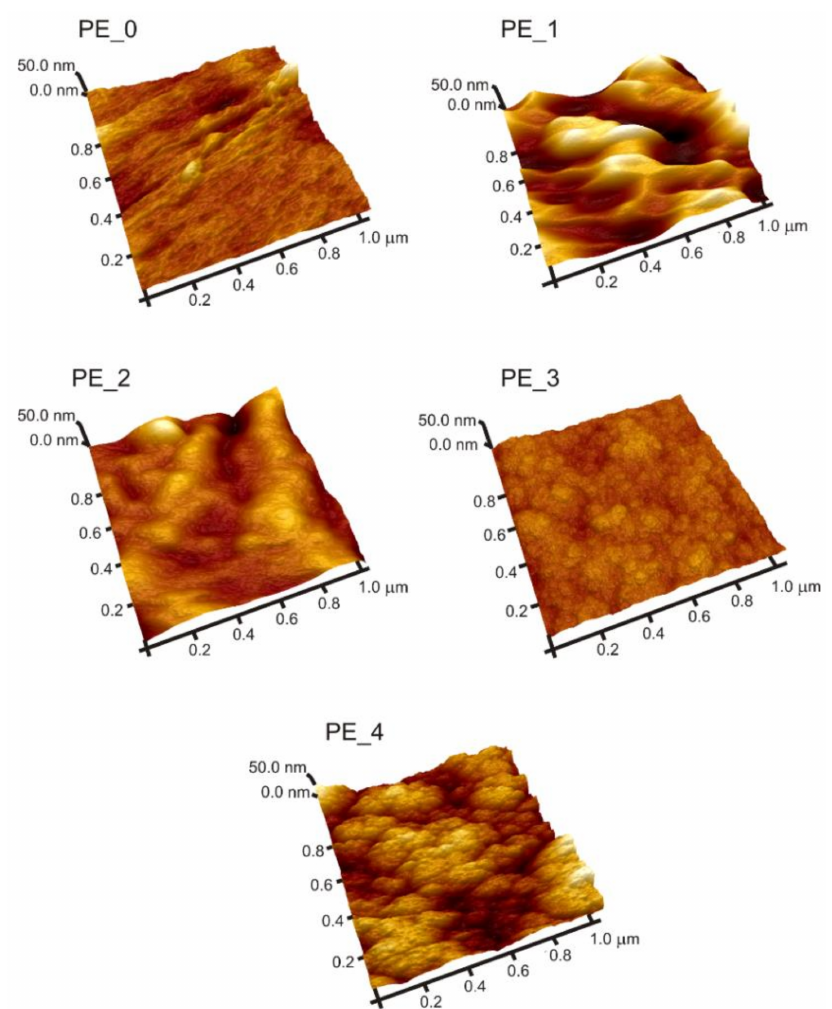
Figure 2. Atomic force microscopy (AFM) images of unmodified PE (PE_0 series) and modified polyethylene surface modification: (PE_1) DLC deposition; (PE_2) N-DLC deposition; (PE_3) N-DLC and DLC deposition; (PE_4) N-DLC and Si-DLC